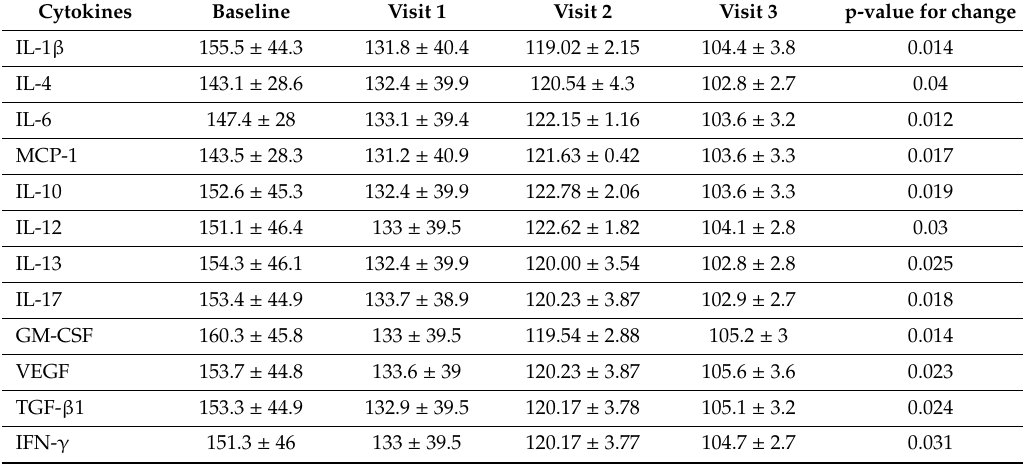
Table 3. PG2-induced alteration in patients’ inflammatory cytokine